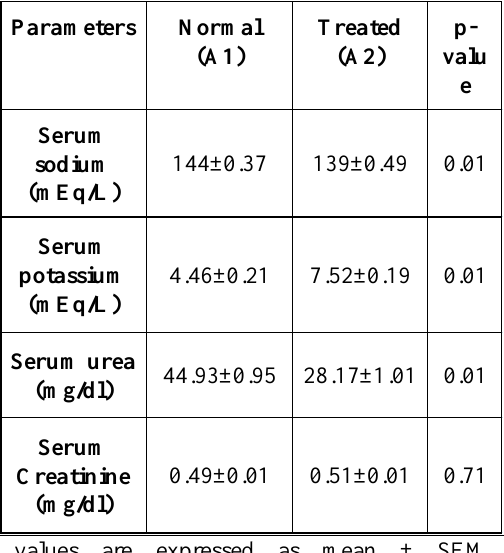
Table 3. Effects of P. farcta fruit decoction (50mg/Kg )on serum electrolytes, serum urea and creatinine concentration in normal rats.